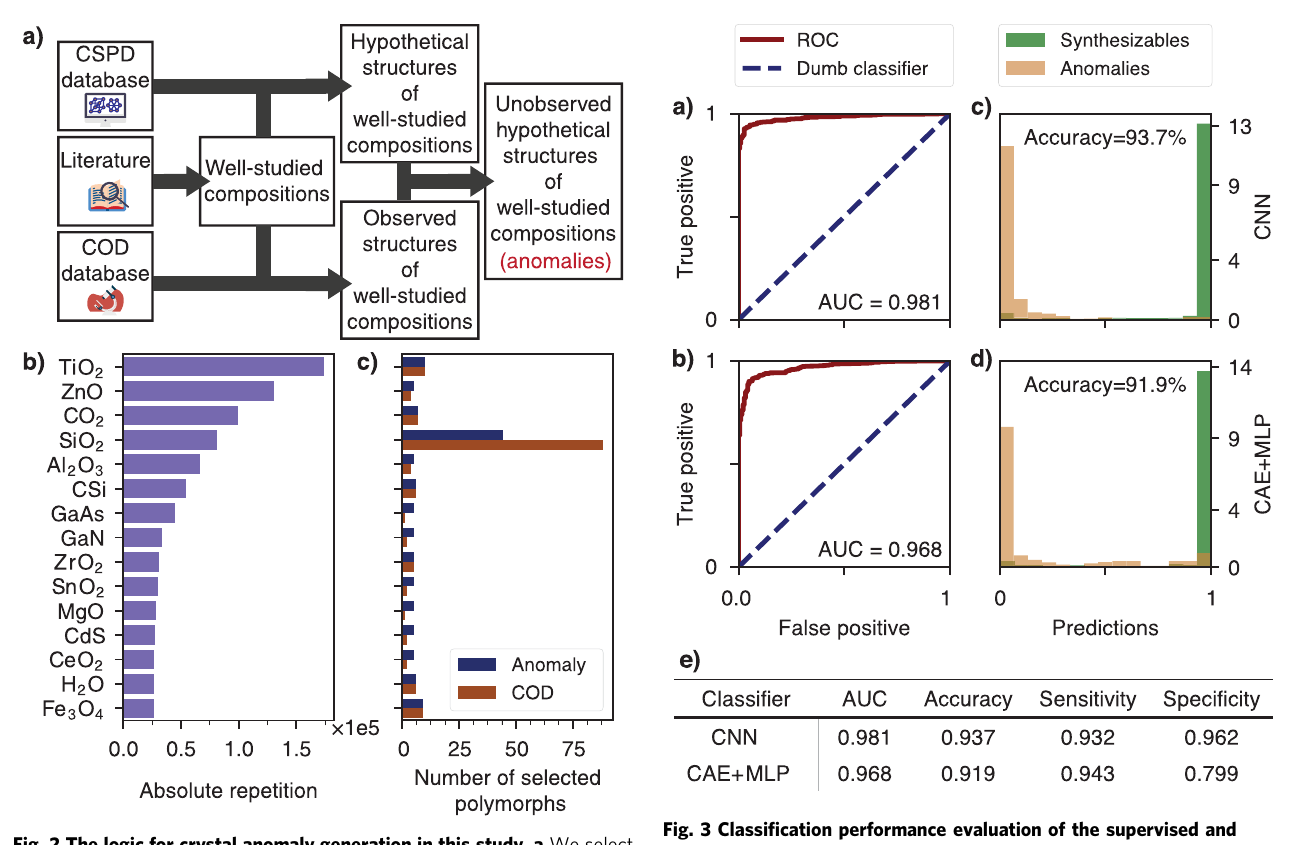
Fig. 2 The logic for crystal anomaly generation in this study. a We select the unobserved hypothetical crystal structures of well-studied compositions in the literature and label them as crystal anomalies. b The total repetitions of the 15 most-studied compositions in materials science literature are shown as an example. We use the top 108 compositions to generate crystal anomalies in this study. c The number of distinct crystal anomalies and observed/synthesized crystal structures for the 15 most- studied compositions are shown by blue and orange bars, respectively. The 15 most-studied compositions are shown as an example while we use the 108 most-studied compositions to generate the anomaly and synthesizable crystal samples.